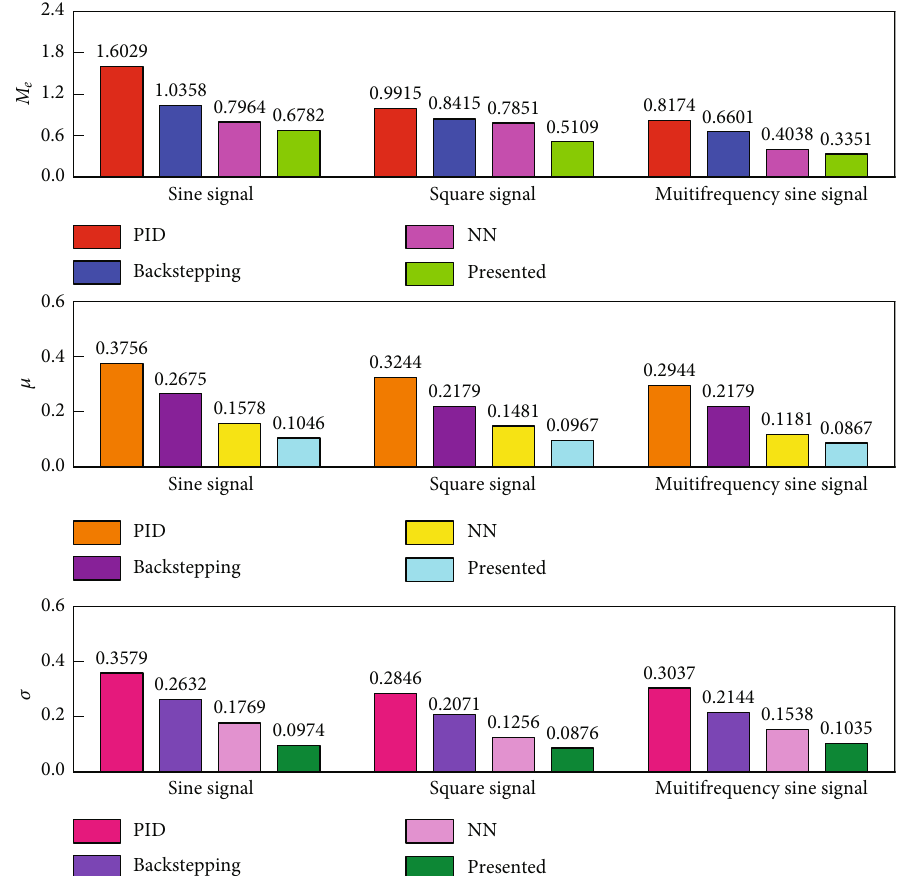
Figure 15: Performance indices of di ff erent controllers for the above three